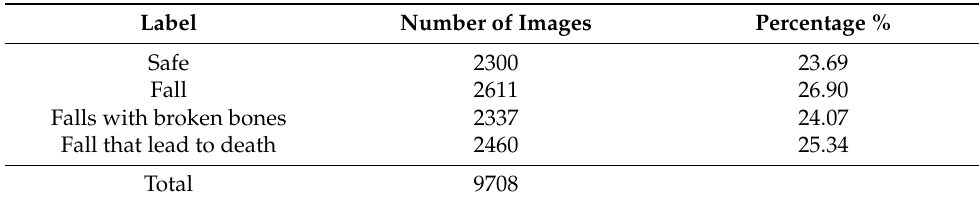
Table 2. Description of the datasets according to safe, fall, falls with broken bones, falls that lead to death cases in the SV-S2017 dataset.